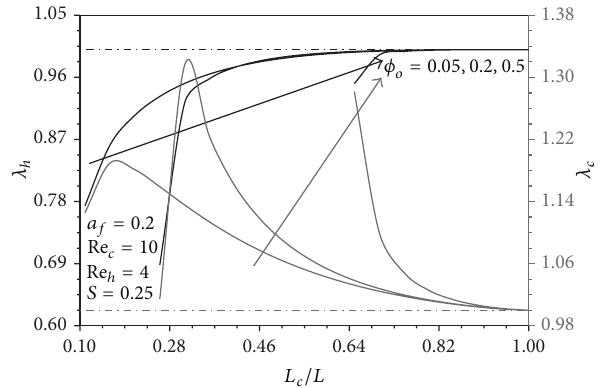
Figure 11: Effects of 𝐿 𝑐 /𝐿 and 𝜙 𝑜 on 𝜆 ℎ and 𝜆 𝑐 .